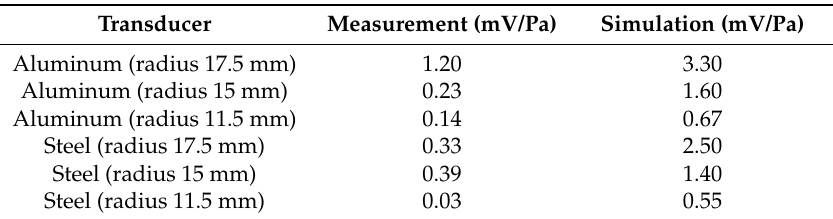
Table 1. Mean sensitivity of the six prototypes between 1 and 2